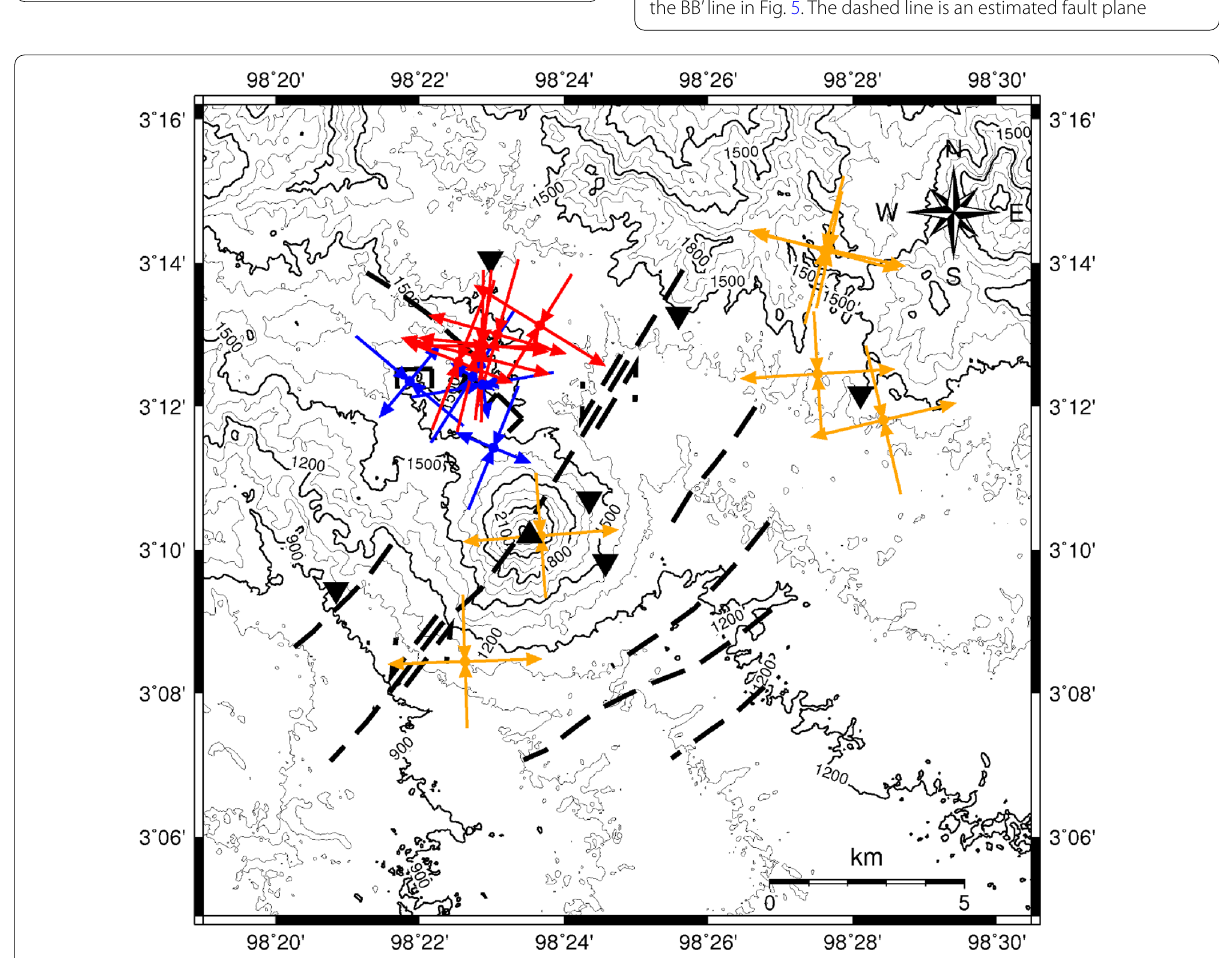
Fig. 8 The P and T axis for all events. The color of each event is according to its group, as shown in Fig.